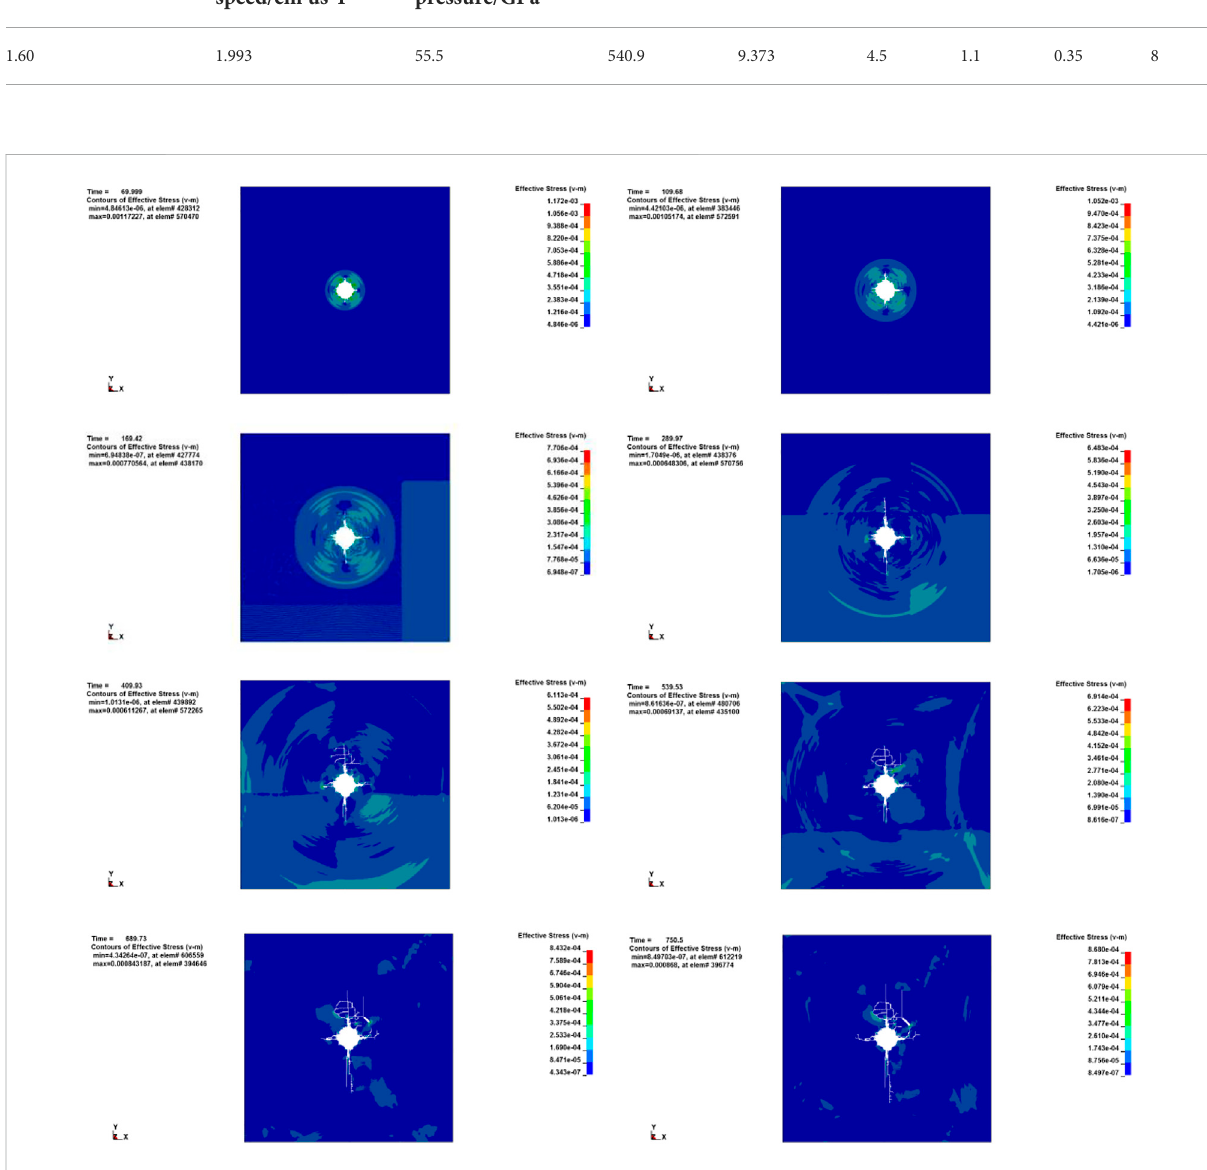
FIGURE 1 Original image of simulation